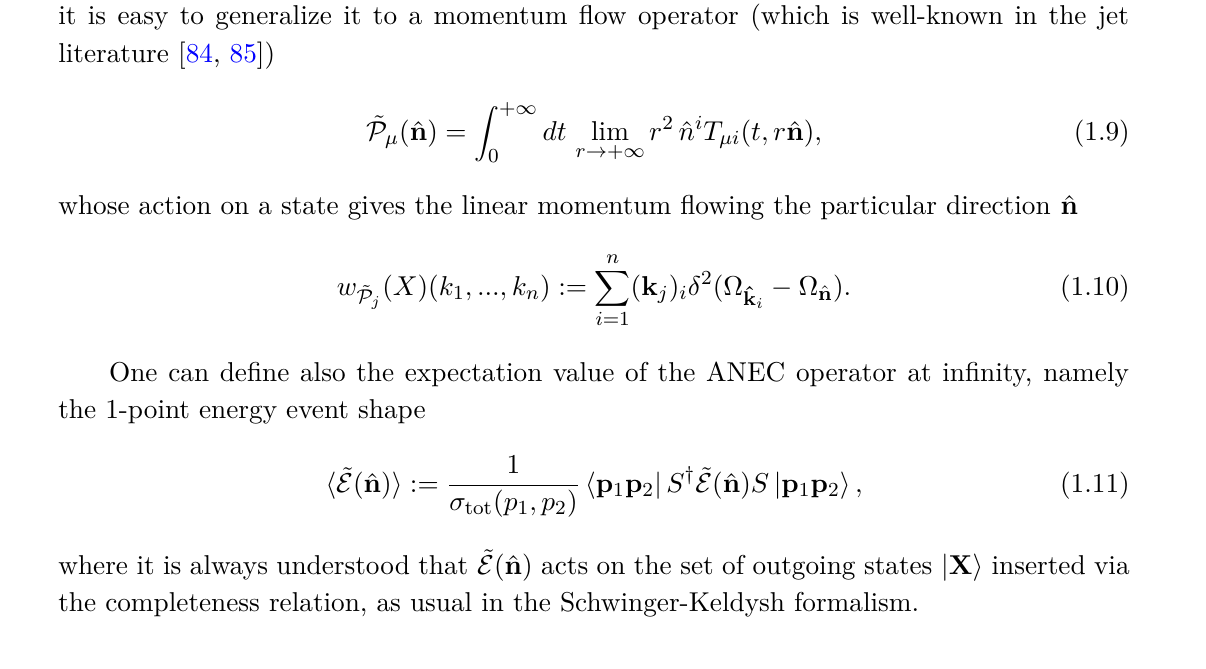
( z ¯ z ) and ˆ n ( z ¯ z ) 1 1 , 1 2 2 , 2